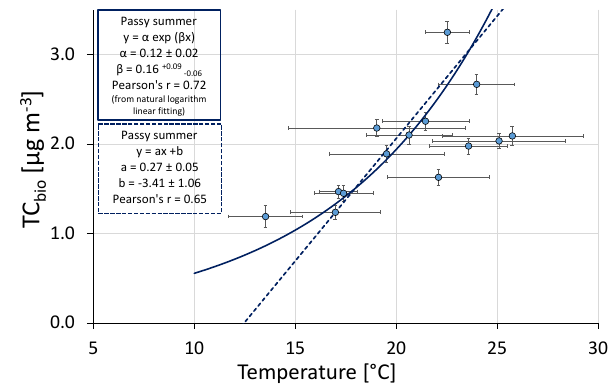
Figure 10. Comparison of TC bio based on levoglucosan and 14 C / 12 C ratio measurements plotted vs. the average temperature of the warmest part of the day (10:00 to 18:00UTC + 02:00). Blue dots stand for the Passy summer samples. TC bio concentration in- creases with the temperature. Both linear (dashed line) and expo- nential (solid line) relations are represented with their correlation coefficient. The fit parameters have been calculated by taking into account both error bars on the x and y axes and are given with their 95% confidence interval. The exponential fit is preferred as the TC bio emission cannot be negative. Moreover, emission of BVOCs (precursors of SOA) emission rate is classically described with an exponential law (Leaitch et al.,